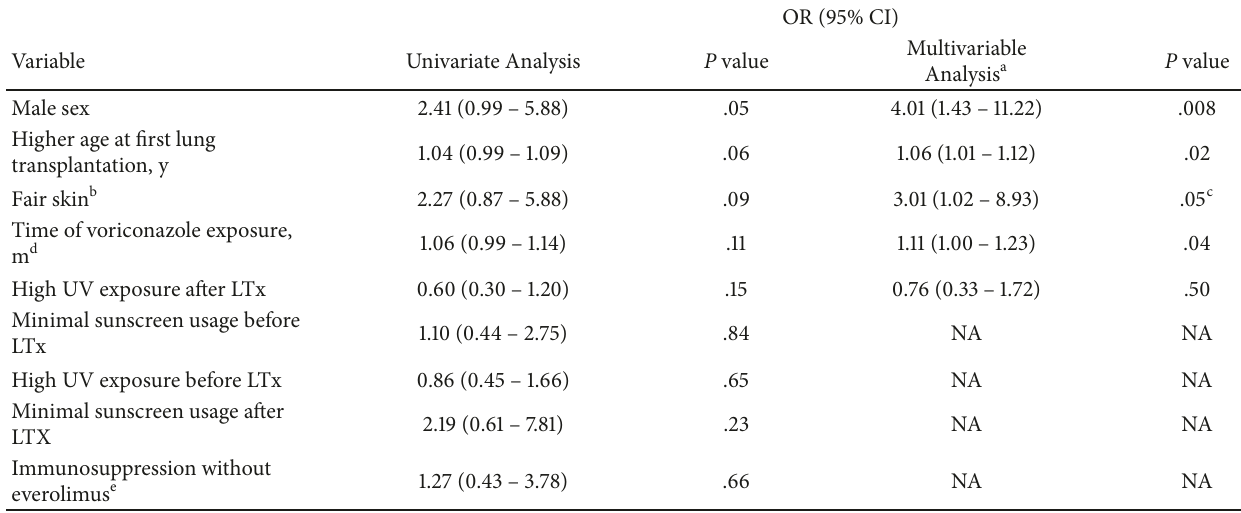
Table 4: Binary logistic regression of risk factors for NMSC or precancerous lesions after lung transplantation.